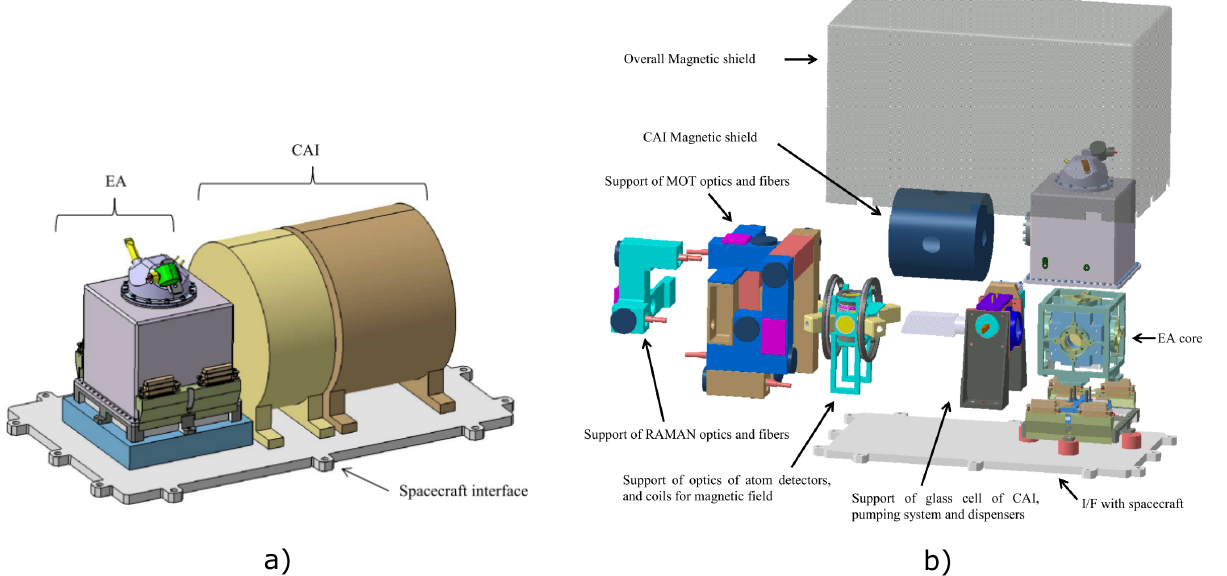
Figure 30. ( a ) Global hybrid instrument architecture. ( b ) Exploded view of the hybrid architecture.